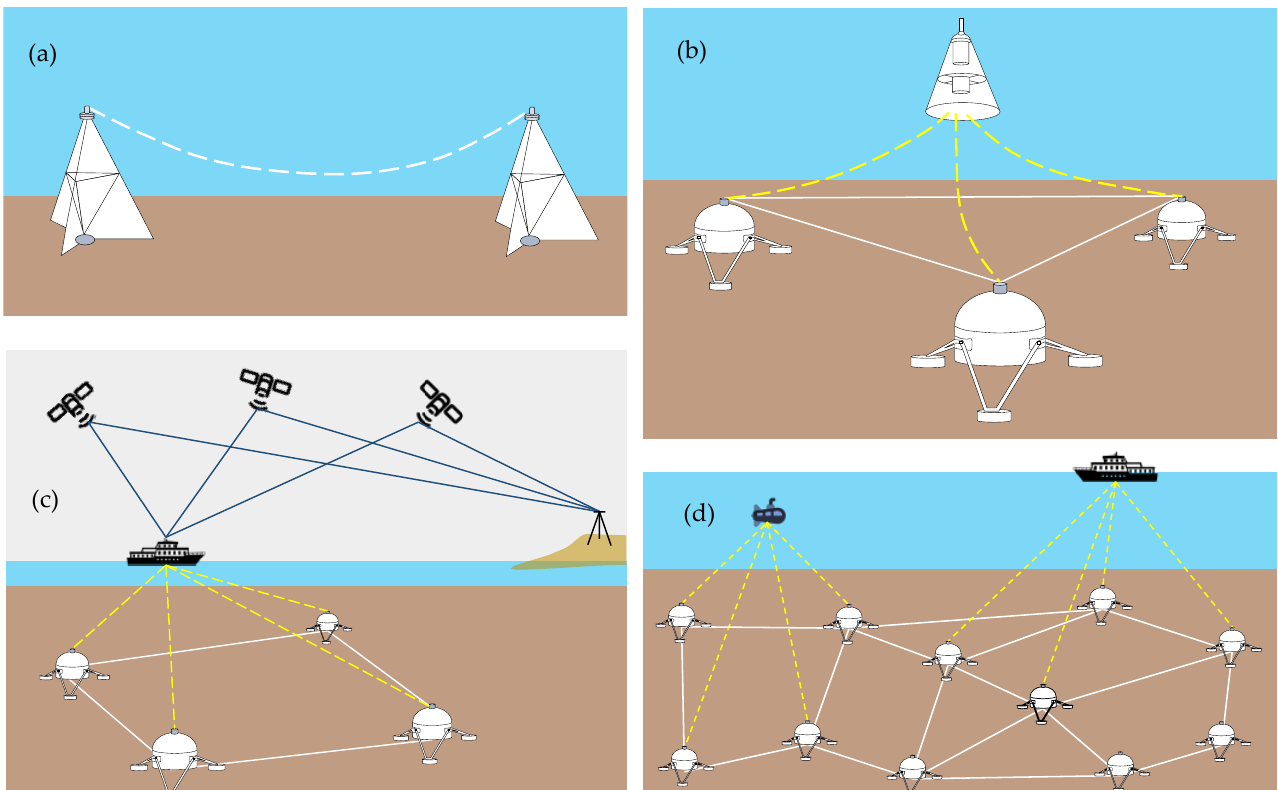
Figure 1. ( a ) The direct‑path acoustic network; ( b ) the indirect‑path acoustic network; ( c ) the GNSS‑A network; ( d ) the seafloor PNT